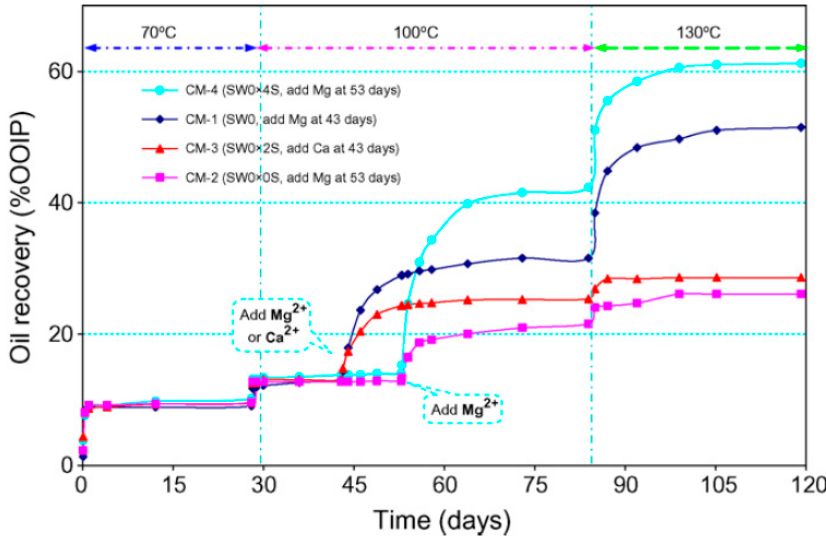
Figure 7. Comparison of spontaneous imbibition rates of PDIs in chalk conducted at 70, 100 and 130 ◦ C. Modified seawater without Ca 2+ and Mg 2+ was initially imbibed and Mg 2+ or Ca 2+ was later added in a systematic variation of PDI concentrations (reproduced from Zhang et al. [59] with permission).